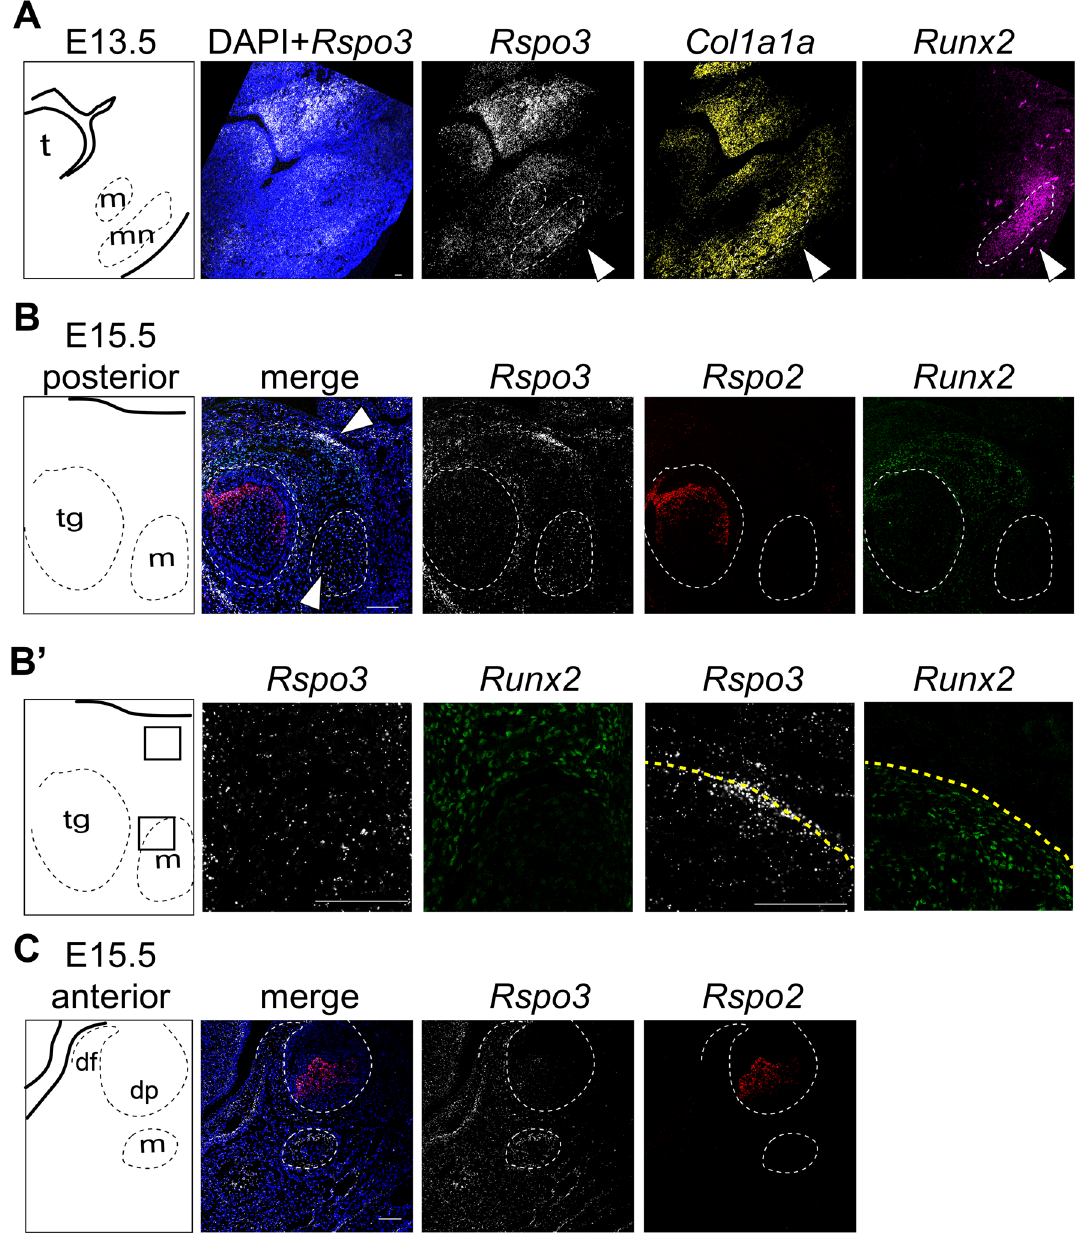
Figure 2. RNAscope gene expression analysis of Rspo2 and Rspo3 in mouse embryos. Coronal sections of wild-type mouse embryos at E13.5 and E15.5. Labeled schematic at left. ( A ) RNAscope revealed diffuse expression of Rspo3 throughout the cranial mesenchyme at E13.5. Col1a1 in situ hybridization and Runx2 immunofluorescence were used to identify osteogenic precursor cells and Rspo3 expression was detected within these cells. Of particular note is Rspo3 expression within Meckel’s cartilage (m) and the developing mandible (arrow; mn). ( B ) At E15.5, Rspo3 expression is detected diffusely thorough the mesenchyme, including in Meckel’s cartilage (m) and within osteogenic precursor cells (co-expressed with Runx2 ). Rspo2 expression is isolated to discrete cells within the developing tooth germ (tg). ( B’ ) Higher magnification images (boxes depict location) of Rspo3 and Runx2 co-expression. ( C ) Within the developing molar at E15.5, Rspo2 and Rspo3 transcripts were detected in distinct non-overlapping regions, with Rspo3 expression in Meckel’s cartilage (m) and the dental follicle (df), while Rspo2 is expressed exclusively within the dental pulp (dp). Scale bar: 100